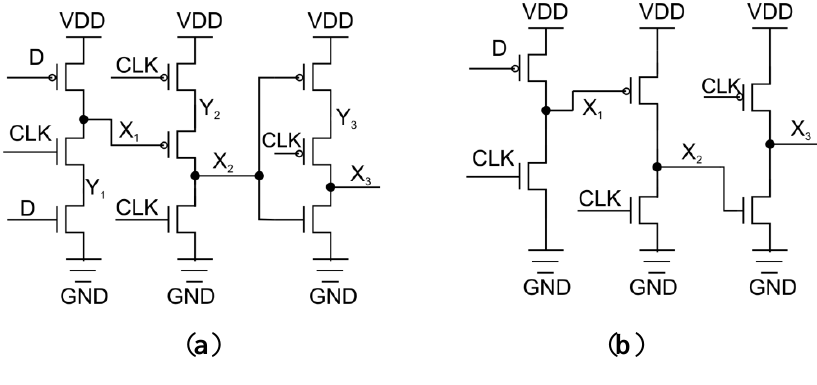
Figure 8. ( a ) True single phase clock (TSPC) based D-FF. ( b ) Extended true single phase clock (E-TSPC) based